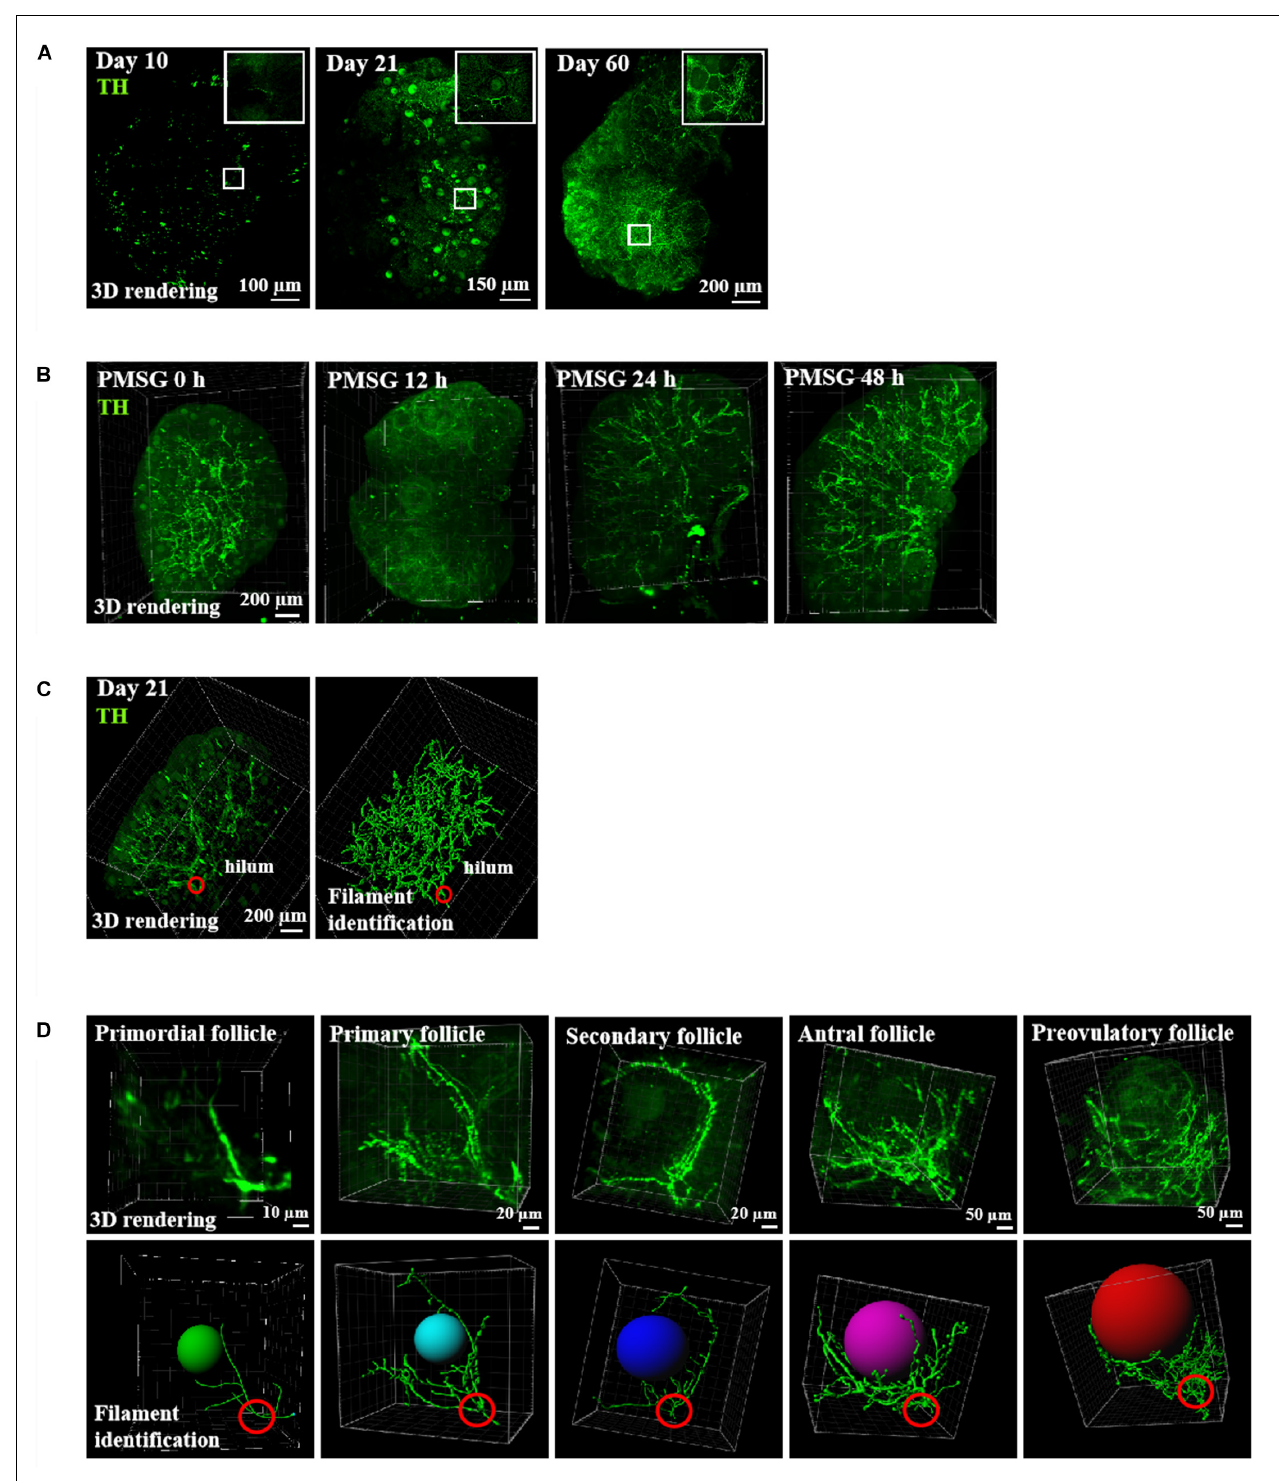
FIGURE 1 | Ovarian innervation of mice at different ages. (A) Ovaries from mice at 10, 21, and 60 days of age were cleared using the CUBIC technique prior to immunostaining using TH antibodies. (B) Ovarian innervation at different time-points after gonadotropin stimulation. (C) Tracing of ovarian nerve fibers of 21-day-old mice. Left panel: TH staining of the whole ovary. Right panel: tracing using the Filament tool in Imaris. (D) Tracing of individual follicles from primordial to primary, secondary, antral, and preovulatory stages.